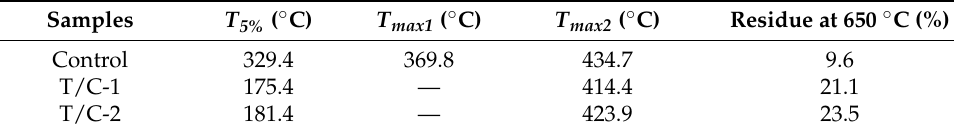
Figure 4. TG ( a ) and DTG ( b ) curves of coated T/C blend fabrics in nitrogen. Table 1. TG data of coated T/C blend fabrics in nitrogen.